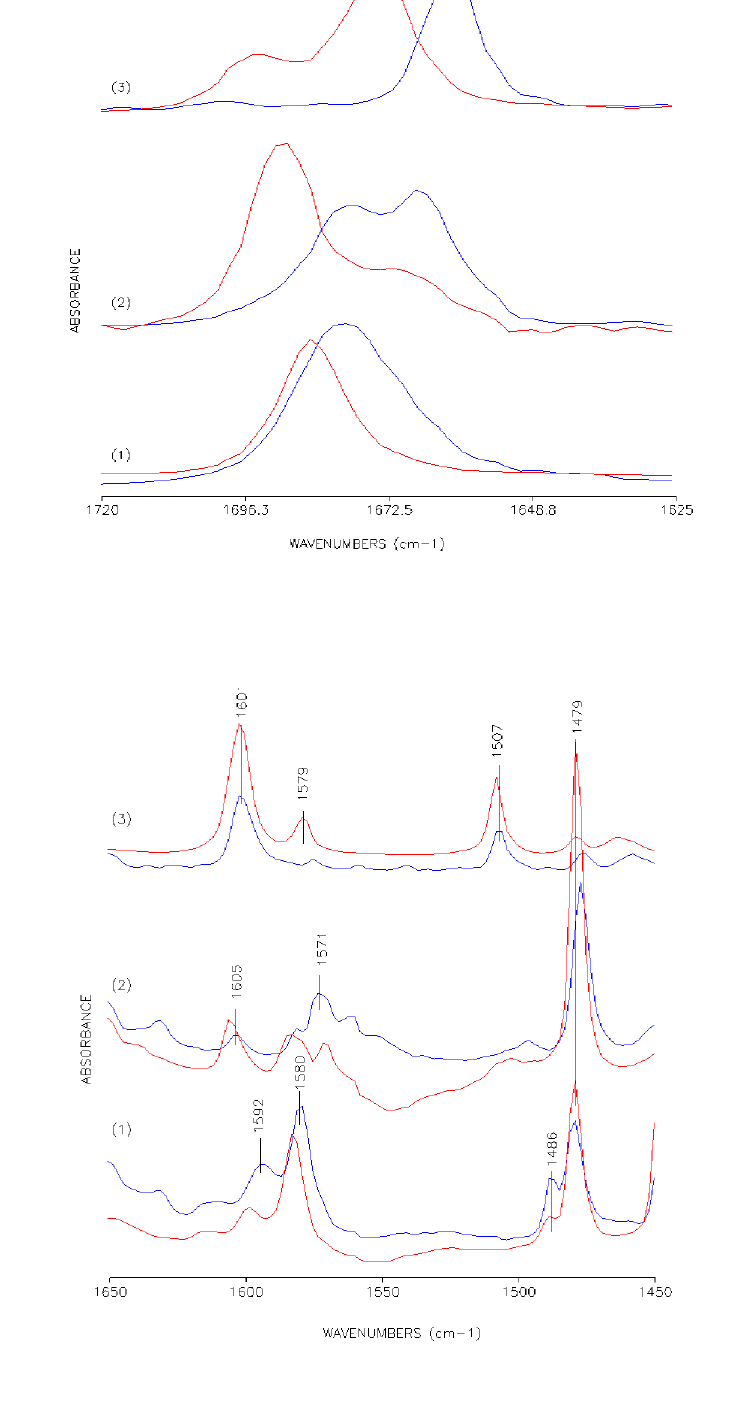
Fig. 4 1720 { 1450 cm ¡ 1 IR spectra of PTB (1), 4’-CNPTB (2) and 4’-MePTB (3); ( ) { in solid state, ( ) { carbon tetrachloride